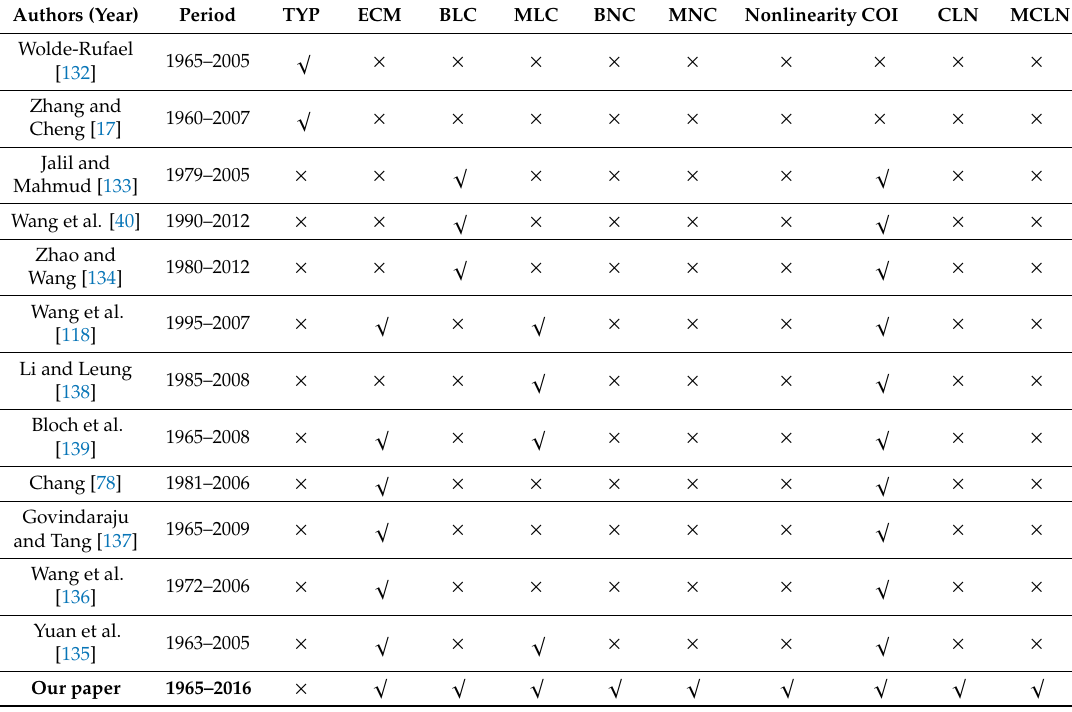
Table A2. Comparison of the methodologies used in this paper and those in the